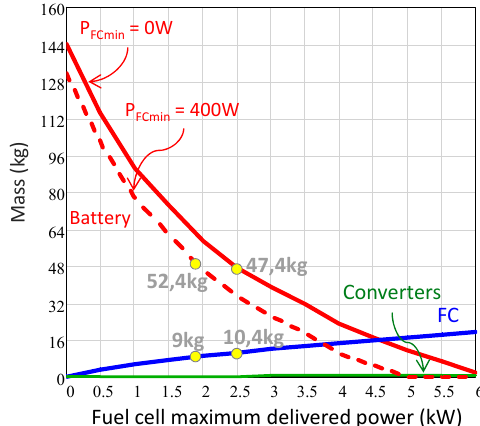
Figure 7. Battery, fuel cell system, and DC-DC converter mass evolution depending on the maximum power delivered by the fuel cell in architecture 1B.